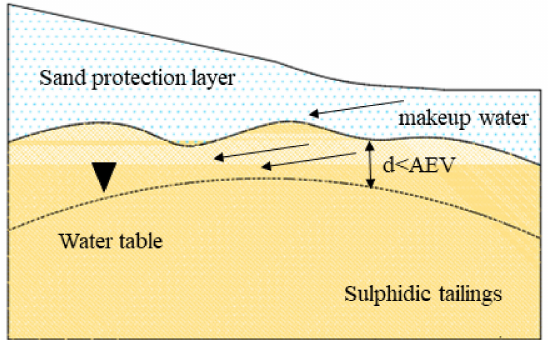
Figure 4. Schematic diagram of elevated water table coverage. (Note: the black triangle indicates the water level depth; the black dotted line indicates that the water level depth is less than the minimum value of AEV; and the black arrow indicates the flow direction of makeup